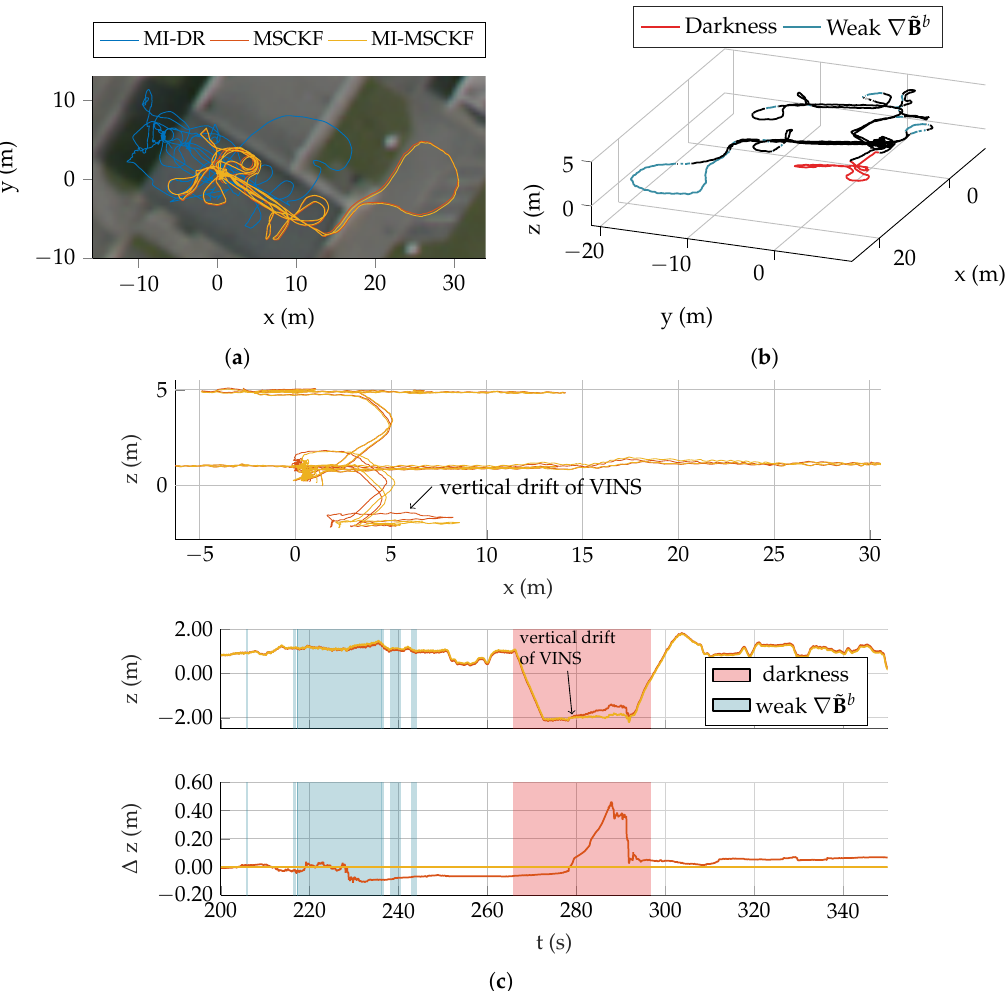
Figure 8. ( a ) Overview of trajectory Traj2 as reconstructed by the three filters. ( b ) Visualisation of dark areas and low-gradient areas over the entire trajectory surimposed on MI-MSCKF estimate. ( c ) Height profile of the three estimators on this